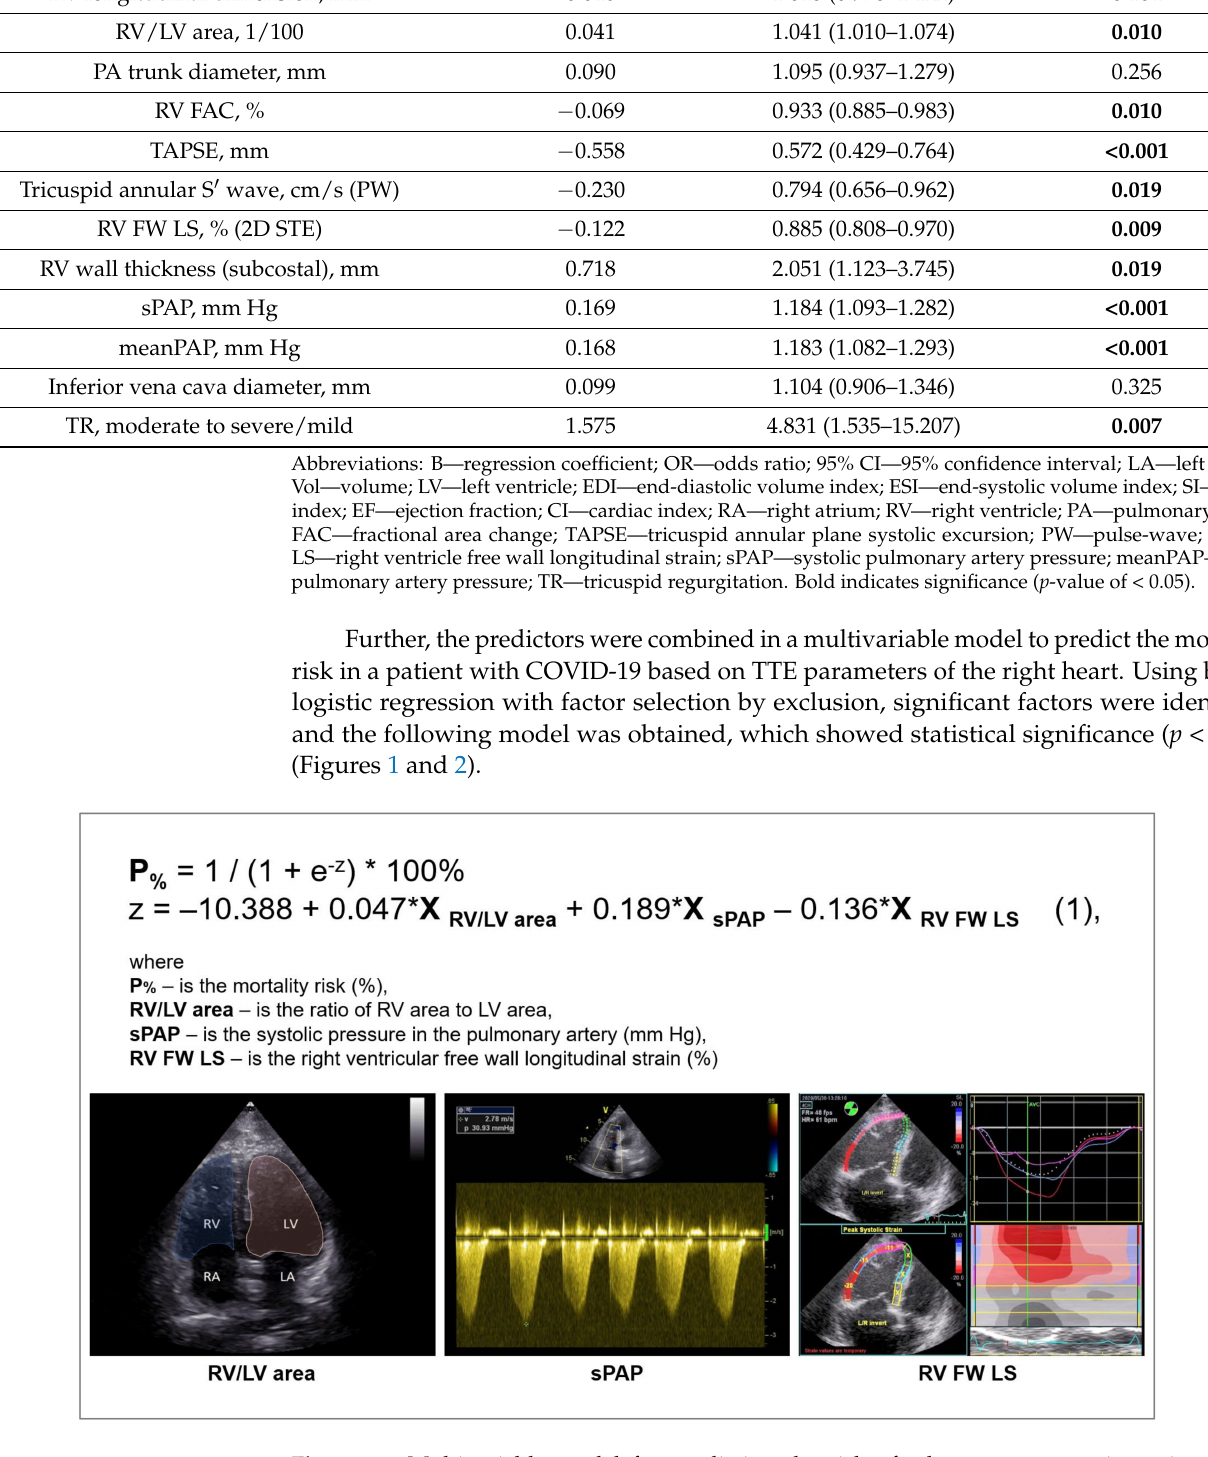
Figure 1. Multivariable model for predicting the risk of adverse outcomes in patients with COVID-19